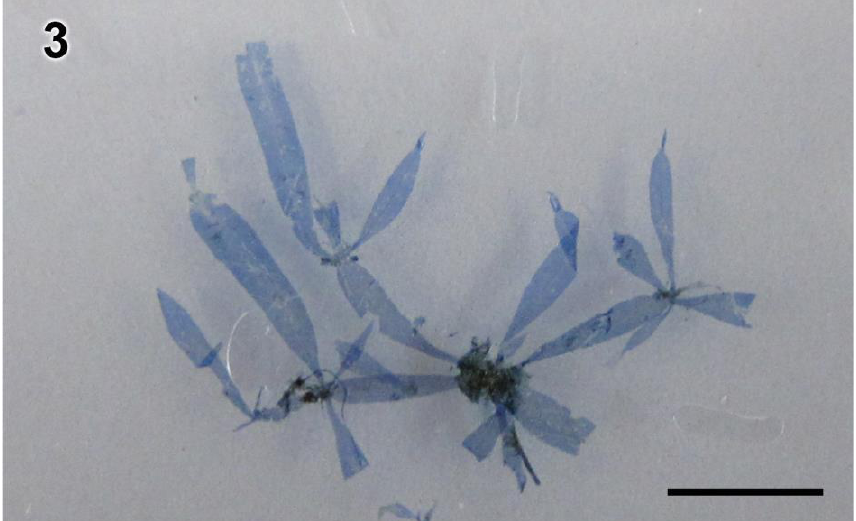
Figure 3. Caloglossa manaticola sp. nov., holotype specimen from sample “ E ” , collected from a West Indian manatee in Crystal River, FL, USA, scale = 4.